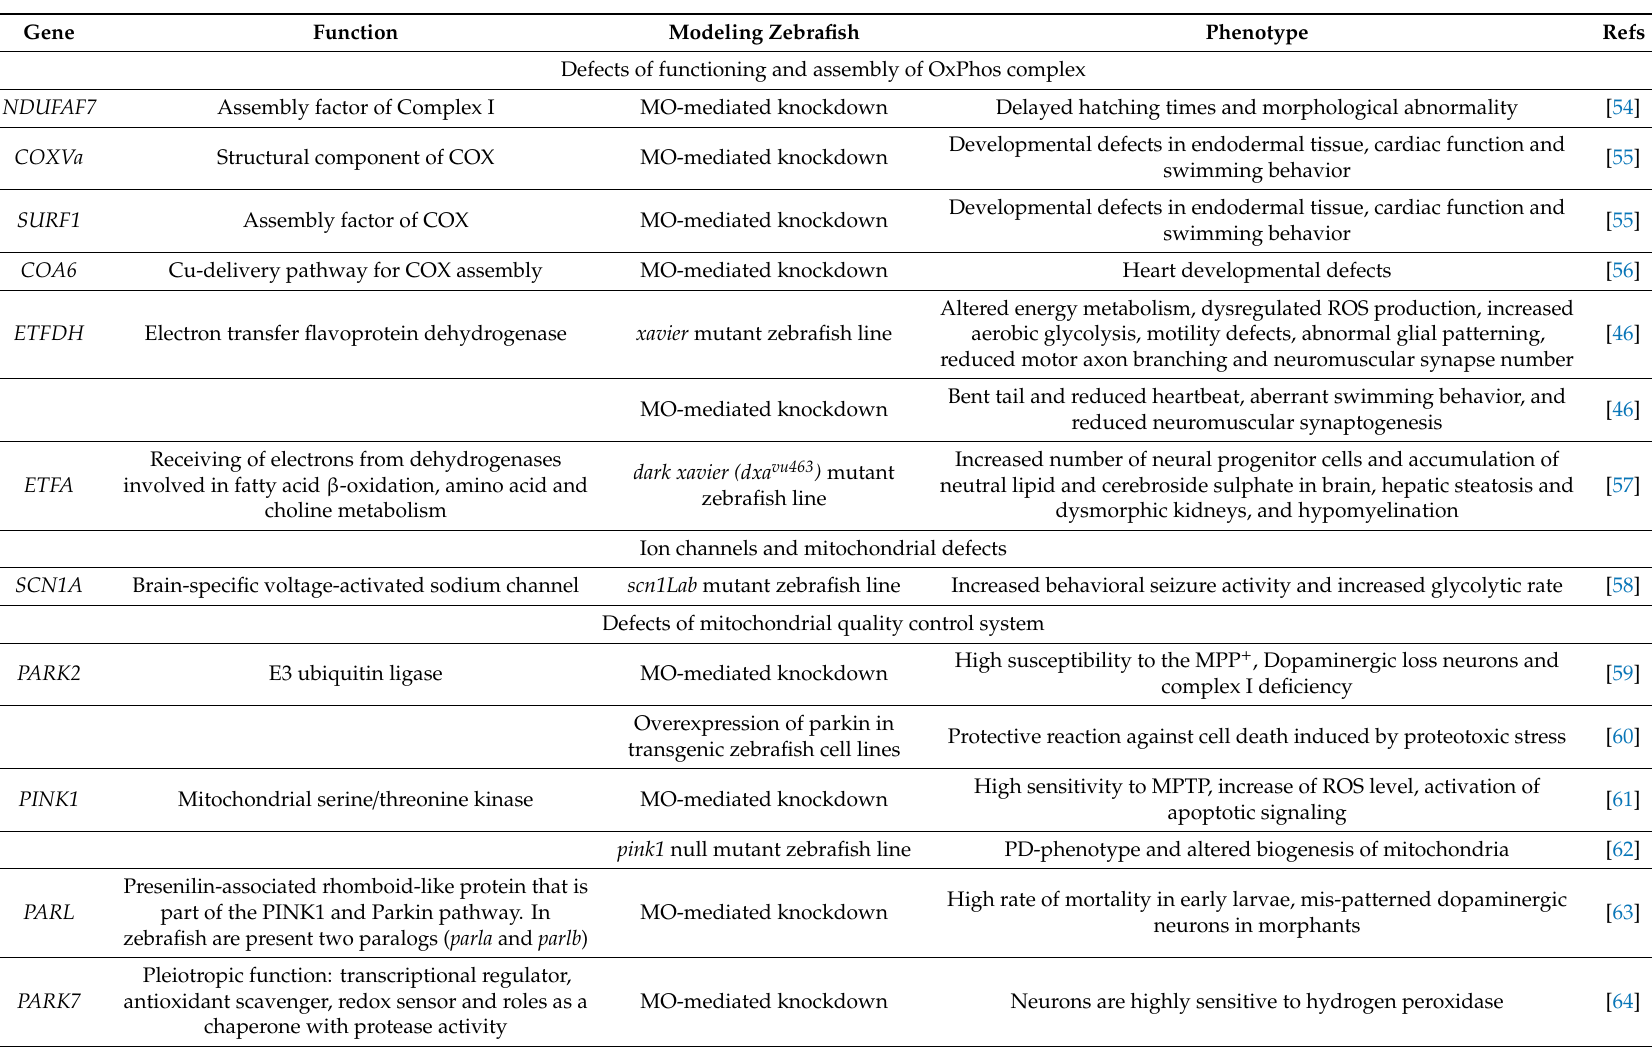
Table 2. Human genes related to mitochondrial disorders a ff ecting the nervous system modeled in